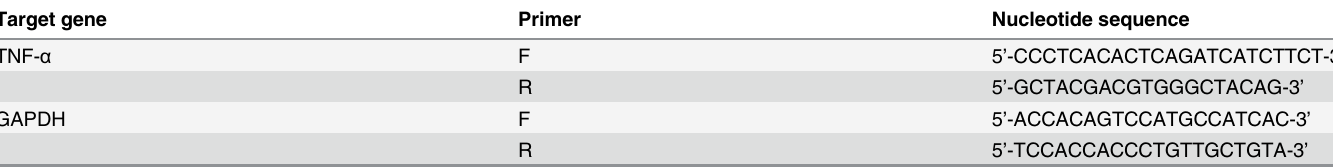
Table 1. Sequences of primer used in quantitative RT-PCR.